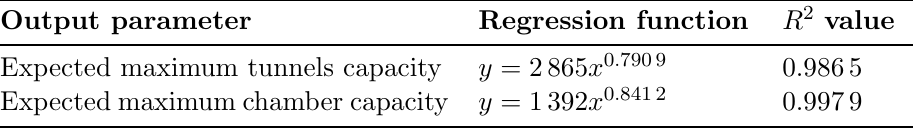
Table 6: Regression functions for capacity